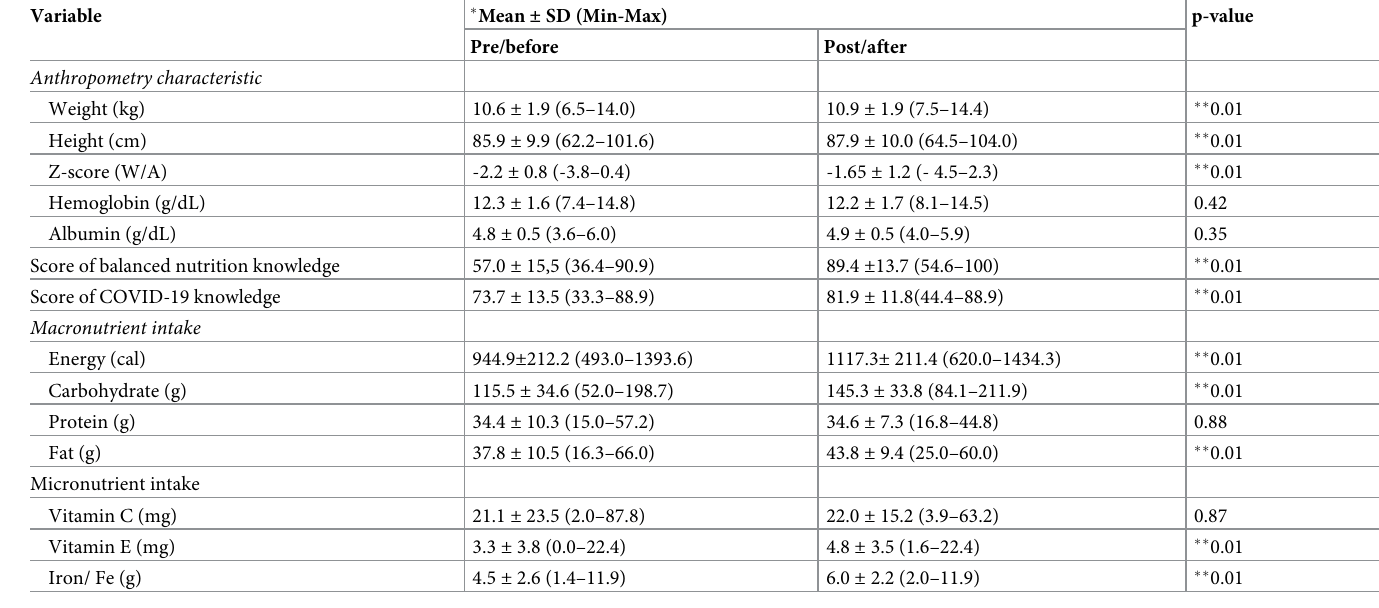
Table 3. Mean changes in anthropometric characteristics of children under-five, knowledge of nutrition and COVID-19, feeding practices of children under-five, and macro and micro nutrient intake at pre-post